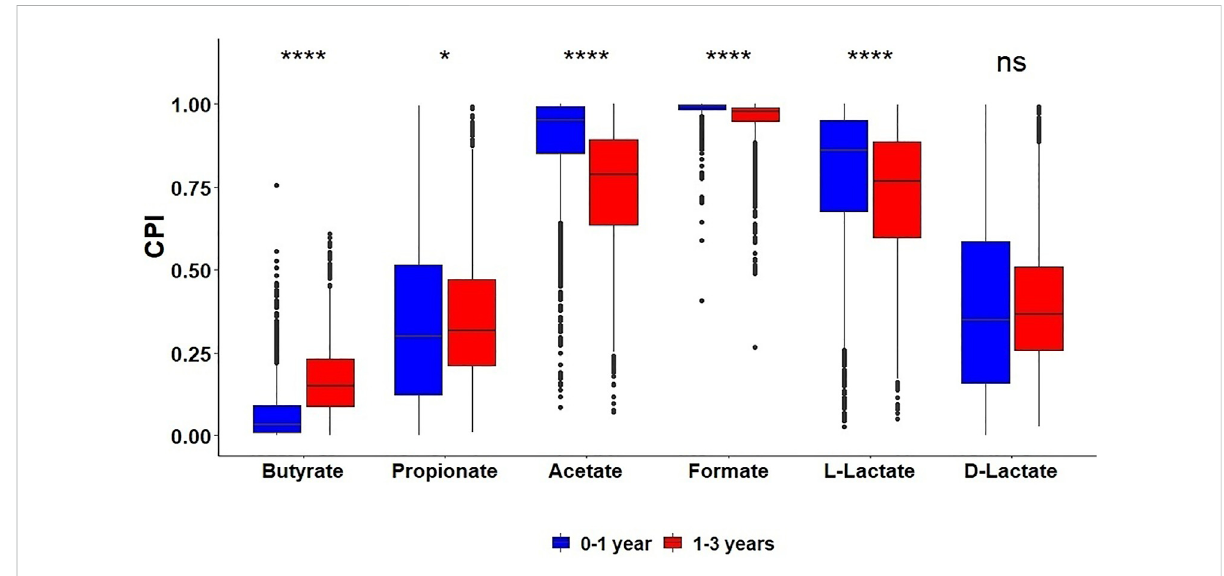
FIGURE 4 Distribution of Community Phenotype Indices (CPI)for SCFAsand lactateinHGM 16Ssamples from theTEDDY dataset among two agegroups of